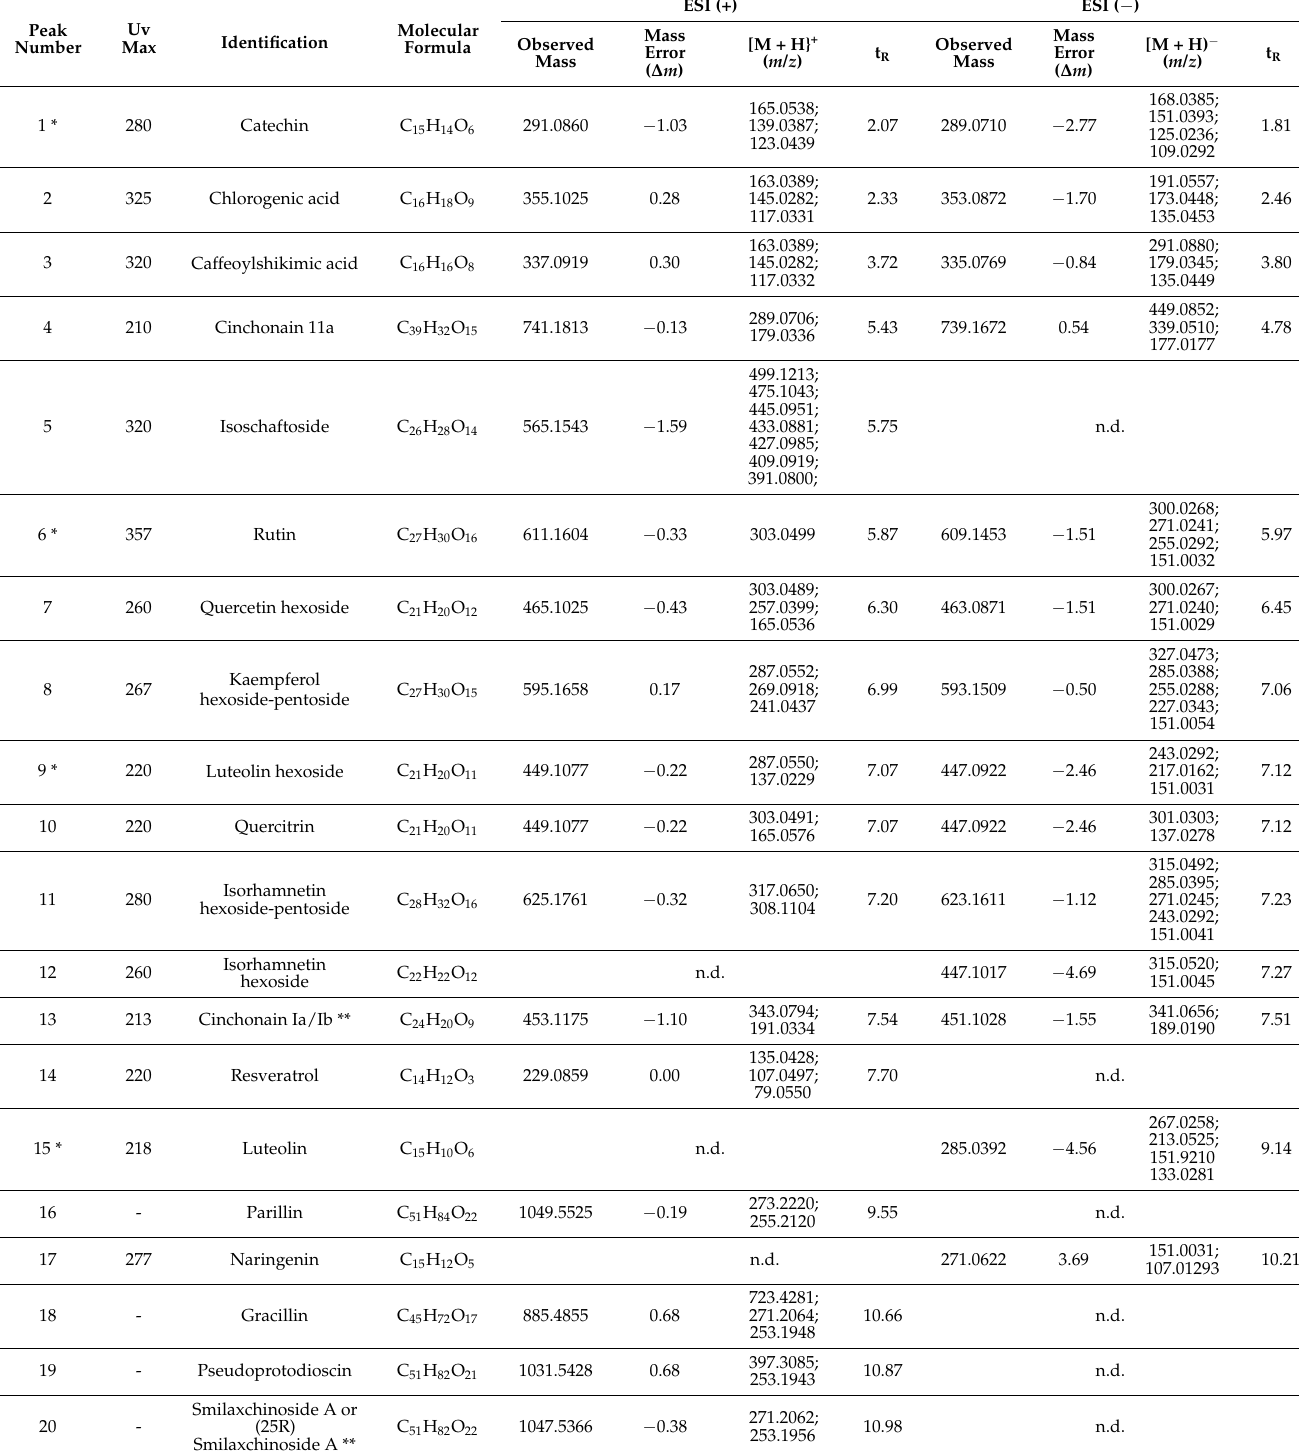
Table 1. Tentatively identified compounds for Smilax aspera leaves and stems at positive and negative ionization